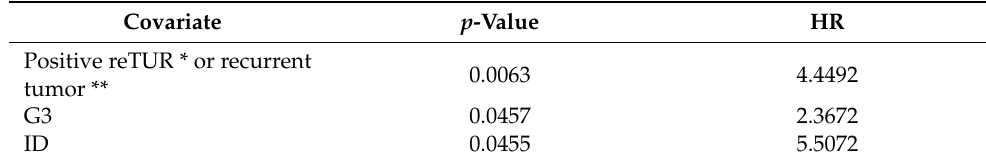
Table 4. Best-performing multivariable Cox regression